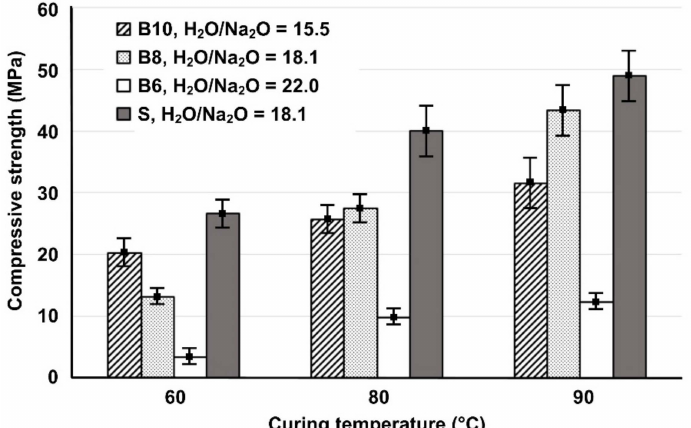
Figure 1. E ff ect of the H 2 O / Na 2 O molar ratio in the activating solutions and curing temperatures on the 7-day compressive strength of brick-and slag-based inorganic polymers (IPs) (Error bars represent the standard deviation of three measurements).